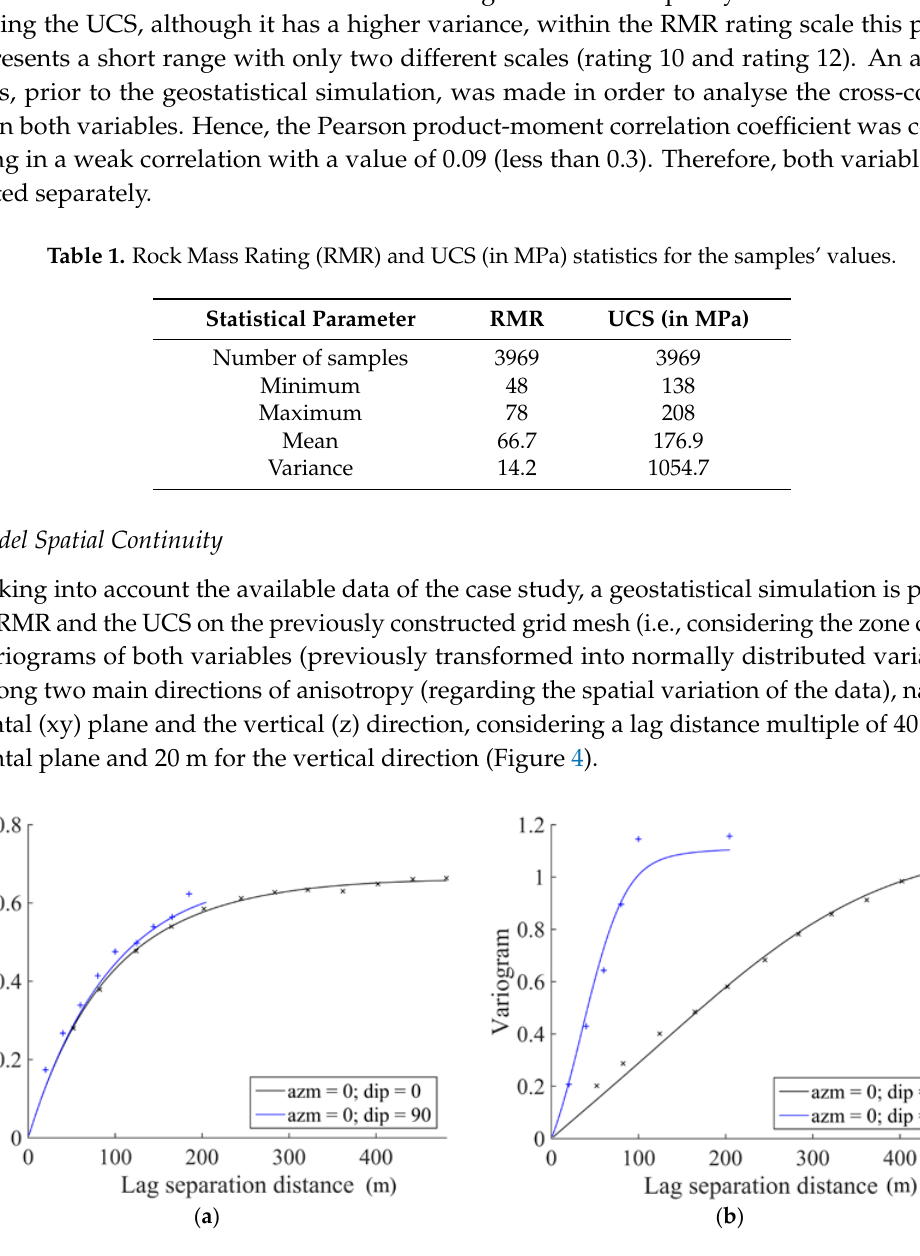
Figure 4. Experimental (crosses) and theoretical (solid lines) variograms along the main anisotropy directions: horizontal plane (black) and vertical (blue): ( a ) RMR; and ( b ) UCS.